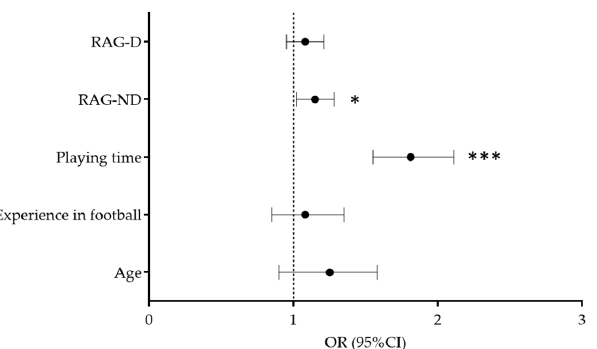
Figure 4. Results of the multivariate logistic analysis in prediction of injury occurrence (*** p <